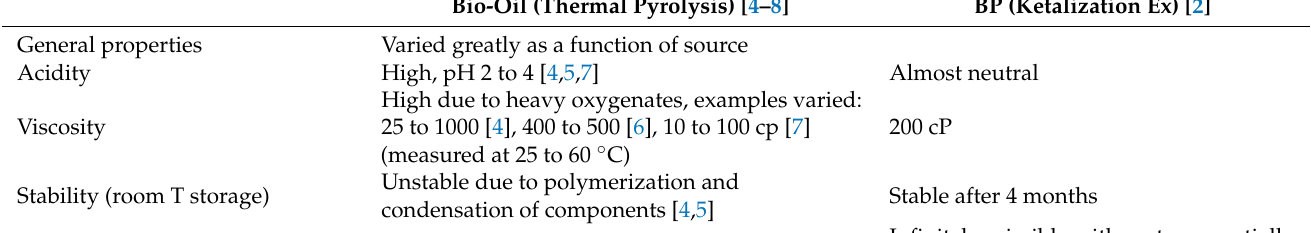
Table 1. A typical bio-oil from thermal pyrolysis compared to bio-petroleum from ketalization. Bio-Oil (Thermal Pyrolysis) [4–8] BP (Ketalization Ex)